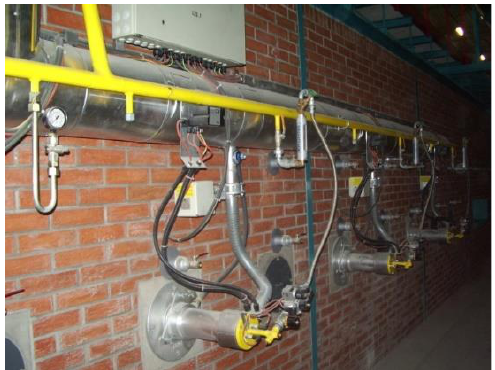
Figure 5. Tunnel firing chamber.